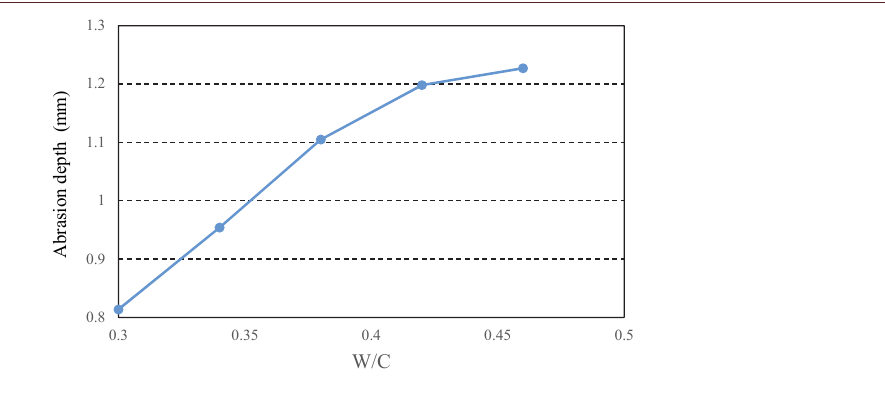
Figure 2: Abrasion depth in terms of water-cement ratio